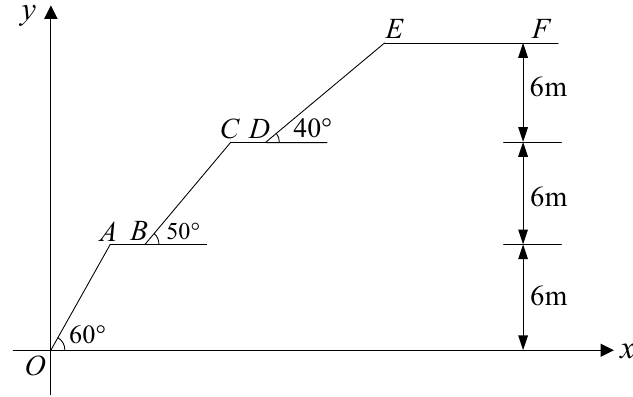
Figure 7. Dimension of the slope in the calculation example (unit: m).